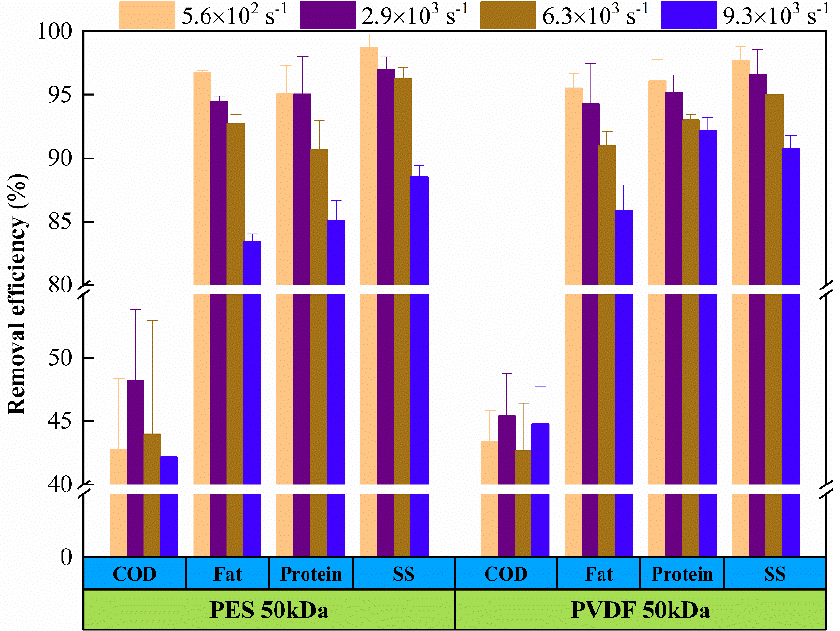
Figure 2. Pollutant removal efficiency of tanning wastewater ultrafiltration at different shear rates (TMP = 1.0 bar).